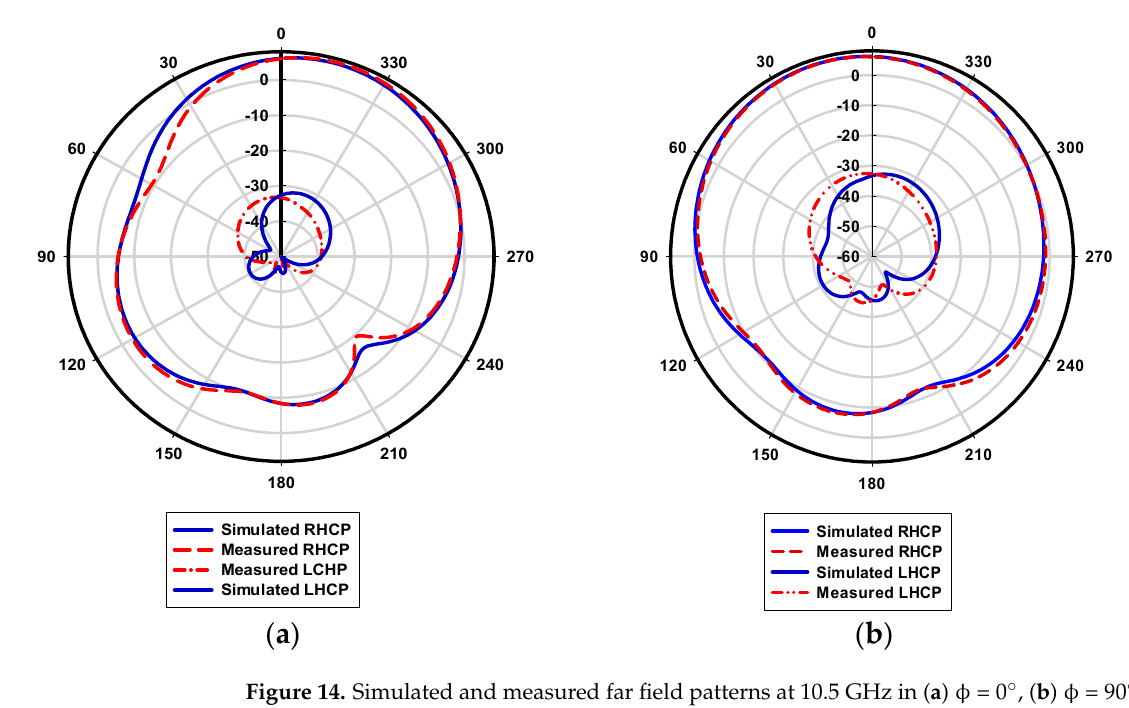
Figure 14. Simulated and measured far field patterns at 10.5 GHz in ( a ) ϕ = 0°, ( b ) ϕ = 90°.